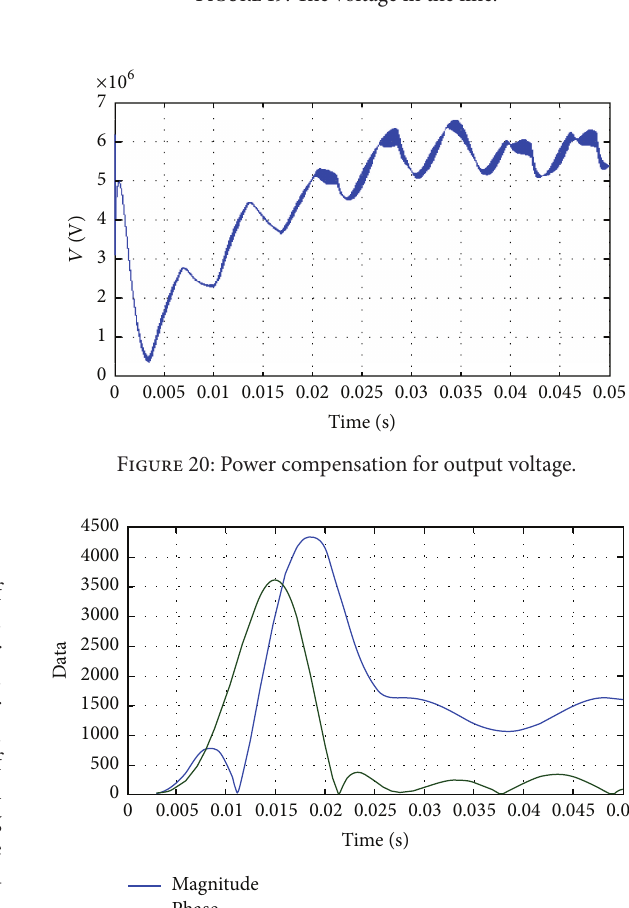
Figure 19: The voltage in the line.